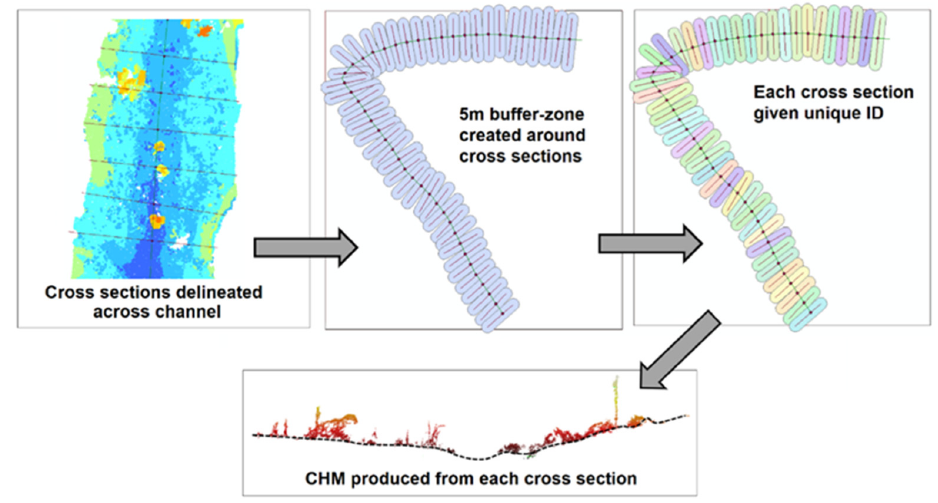
Figure 5. Process of creating CHMs at each cross section. First the cross sections are defined, buffer zones are created around each cross section and given a unique ID, then the point clouds are clipped around each buffer to create these unique CHMs at each cross section.